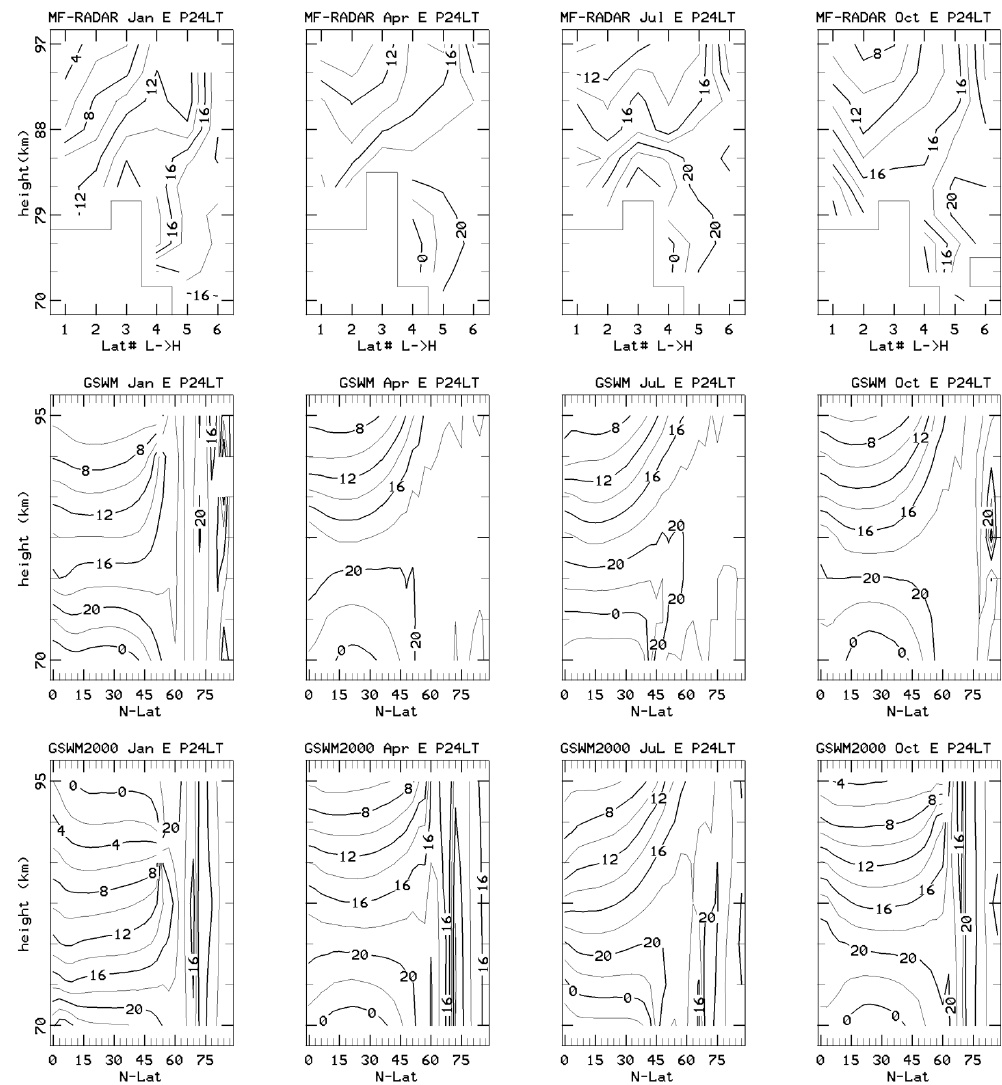
Fig. 10. Phase (P24) contour plots for the 24h Tide. Otherwise as for Fig.